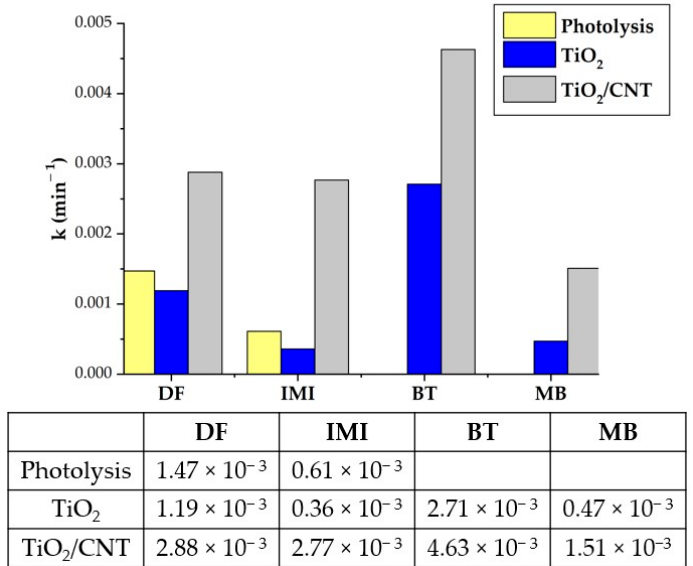
Figure 3. Photolytic and photocatalytic (TiO 2 , TiO 2 /CNT) degradation rate constants k (min − 1 ) according to pseudo-first-order kinetic model for studied model pollutants (DF, IMI, BT, and MB). Even though degradation of DF by hydroxyl radicals follows second-order kinetics, with approximation of steady-state concentration of hydroxyl radicals, reaction is usually treated as a pseudo-first-order kinetic model [7]. Furthermore, for highly diluted systems (C 0 < 10 − 3 M), the reaction can be considered pseudo-first order [64]. In this paper, as it can be seen on Figure 3, degradation rates of both photolysis ( k DF = 1.47 × 10 − 3 min − 1 , = 1.19 × 10 − 3 min − 1 , R 2 = 0 × k = R 2 = 0.99) and photocatalysis ( k DF,TiO DF,TiO 2 /CNT 2 2.88 × 10 − 3 min − 1 , R 2 = 0.99) fit into pseudo-first order